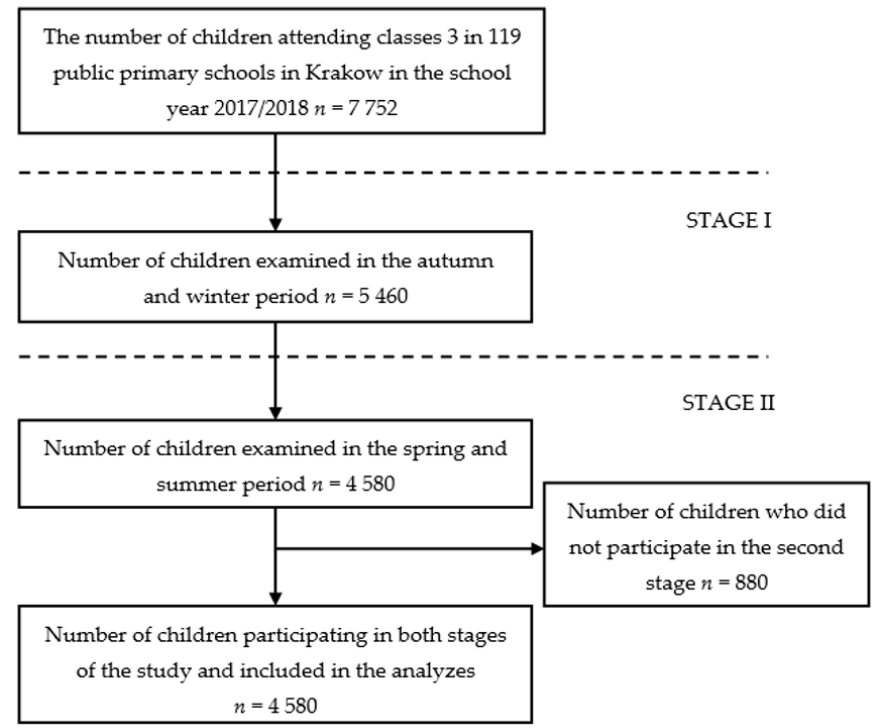
Figure 1. A flow-chart demonstrating the selection of studied